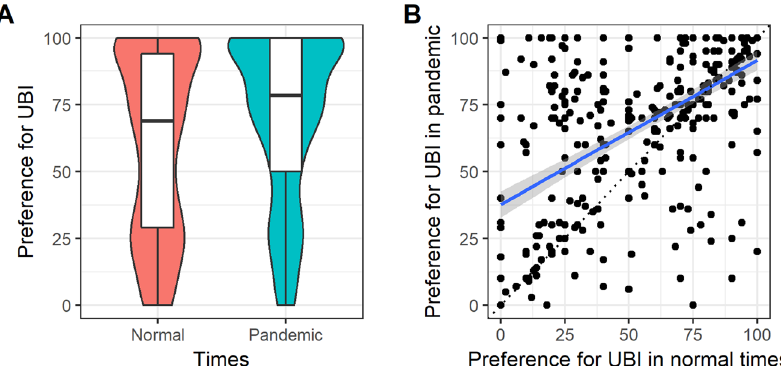
Fig. 3 Support for UBI in study 2. A . Boxplots of preference for UBI versus a targeted system in normal and in pandemic times. Violins show the distribution of the data. B . Individual responses for preference for UBI versus a targeted system in normal and pandemic times. The dotted line shows the line of equality, whilst the solid line is a linear fi t through the data.